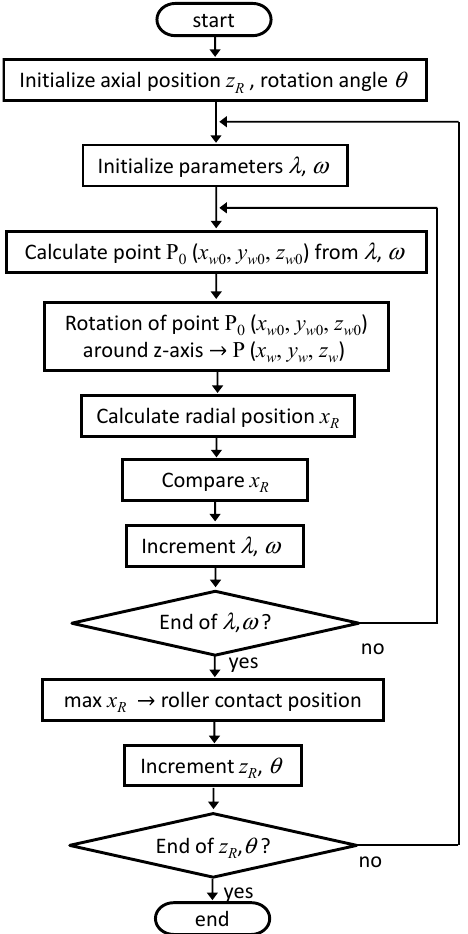
Figure 3. Computation algorithm for searching the roller contact position with the target shape.